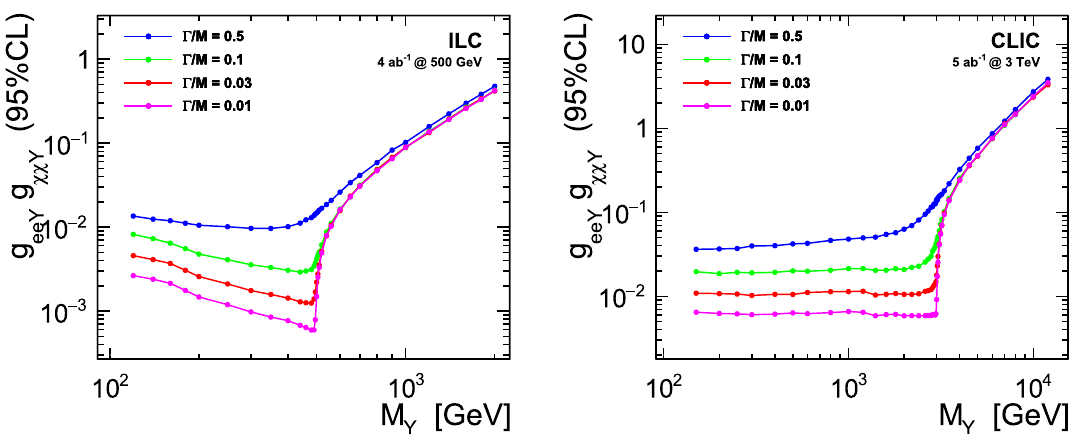
Fig. 16 Limits on the product of the vector mediator couplings to electrons and to DM particles for the ILC running at 500GeV (left) and CLIC running at 3TeV (right) and different fractional mediator widths, as indicated in the plot. Combined limits corresponding to the assumed running scenarios are presented with systematic uncertainties taken into account. Pair-production of Dirac fermion DM is